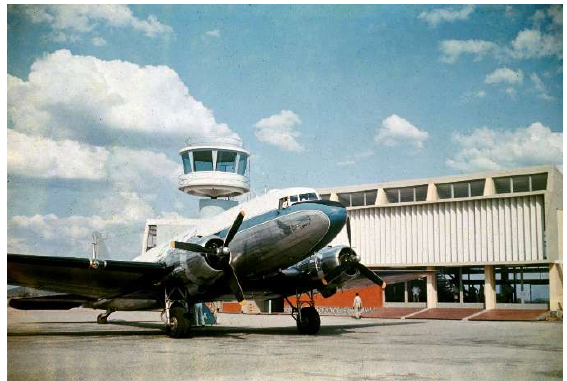
Figure 9. João José Tinoco, Maria Carlota Quintanilha and Alberto Soeiro. Nampula Airport, Figure 9. Jo ã o Jos é Tinoco, Maria Carlota Quintanilha and Alberto Soeiro. Nampula Airport, Mozambique, 1958–1960 (photograph, circa 1960). AHU: AGU / DD1955. (Credits: Portugal,